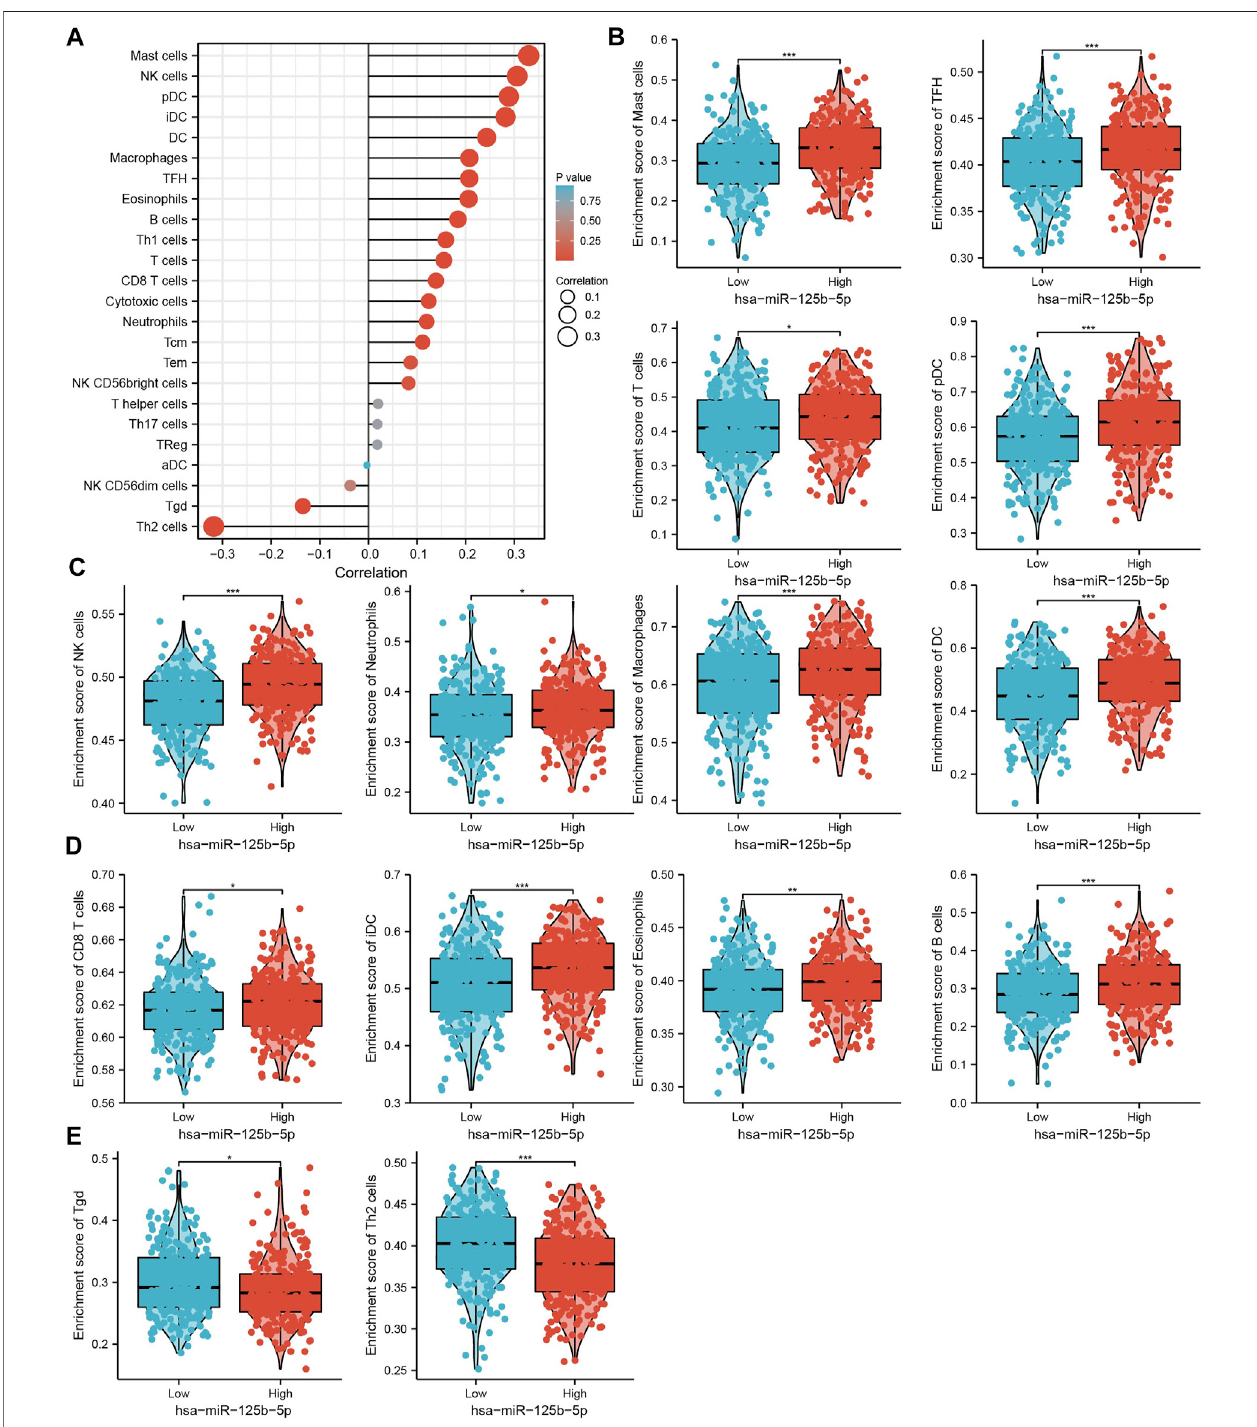
FIGURE 8 | Analysis of the correlation between the expression of miR-125b-5p and immune in fi ltration. (A) Correlation between the relative abundance of 24 immune cells and the expression level of miR-125b-5p. (B – E) Diverse proportions of immune cell subtypes in tumor samples in high and low miR-125b-5p expression groups. * p < 0.05, ** p < 0.01, *** p < 0.001.